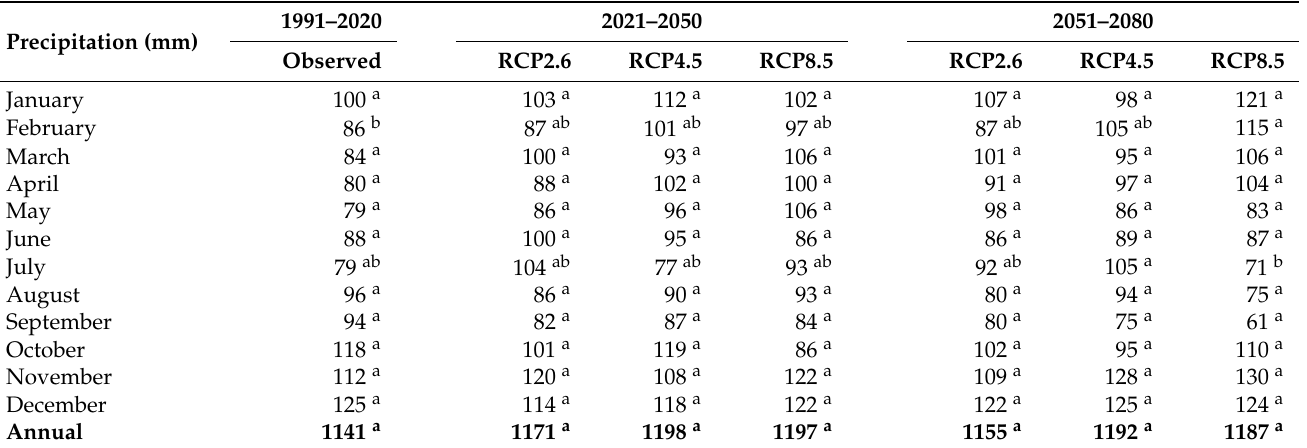
Table 9. Average precipitations (mm) observed in the central zone (Charlottetown) during the 2000s and expected under different projections during the 2030s and